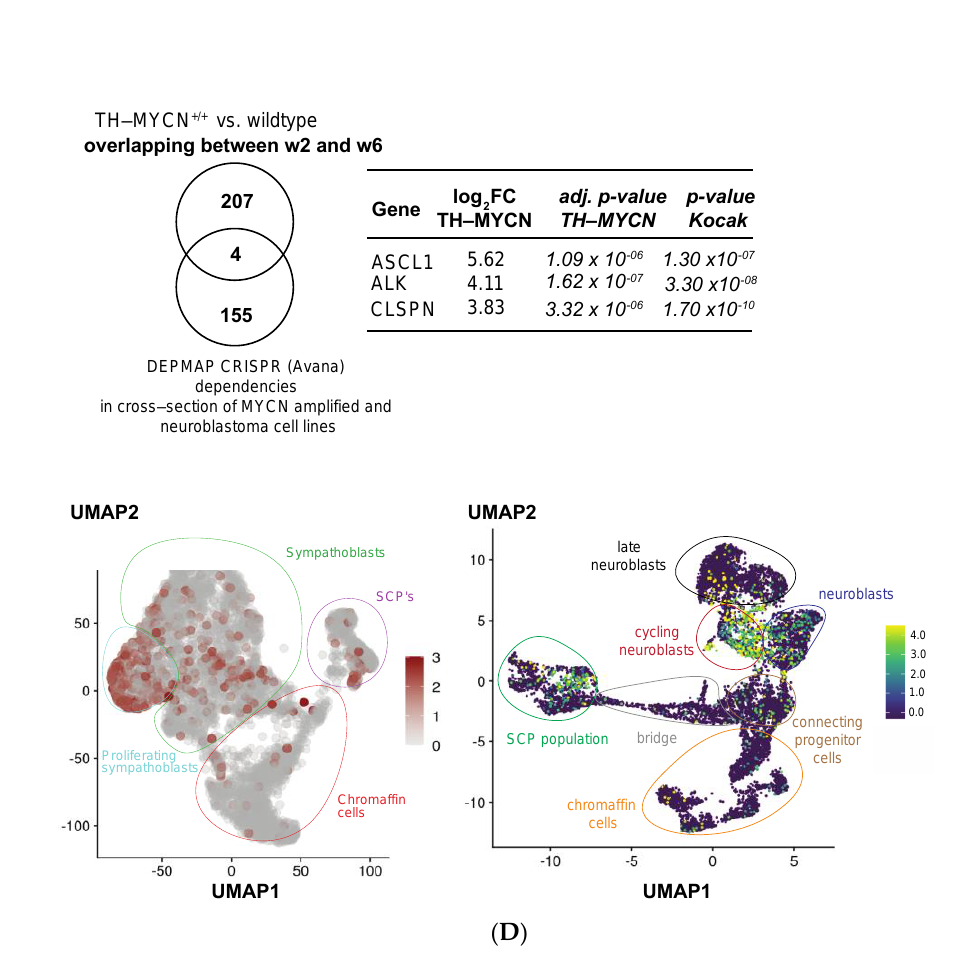
Figure 5. Identification of MYCN-driven dependencies during murine TH-MYCN driven neuroblastoma tumor formation. ( A ) (left) Overlap between upregulated genes in TH-MYCN +/+ versus wild-type samples upon 2 weeks after birth compared to Week 1, with 159 candidate genetic dependencies that were commonly found by the DEPMAP initiative (Avana CRISPR screen) as hits in MYCN-amplified and neuroblastoma cell lines and (right) Overlap between upregulated genes in TH- MYCN +/+ versus wild-type samples upon 6 weeks after birth compared to Week 1, with 159 candidate genetic dependencies that were commonly found by the DEPMAP initiative (Avana CRISPR screen) in MYCN-amplified and neuroblastoma cell lines (left), with an overview of 15 of the overlapping genes significantly correlated with poor overall patient survival in primary neuroblastoma tumors (GSE45547, n = 649) displaying their corresponding log 2 fold change and (adjusted) p -value (right). ( B ) (left) Single-cell analysis of CDCA8 expression in the developing sympathoadrenal lineage points towards nearly exclusive expression in proliferating sympathoblasts [49] (SCP: Schwann cell precursor); (right) single-cell analysis of CDCA8 expression in different cell populations of the adrenal medulla [50]. ( C ) Kaplan–Meier analysis of overall patient survival based on gene expression levels of CBX2 , GJC1 and LIMD2 , encoded on chromosome 17q in a large cohort of 649 primary neuroblastoma patients (GSE45547, n = 649) with high or low expression using median as a cut-off. p -values are a result of a log-rank test. ( D ) (top) Overlap between commonly upregulated genes in TH-MYCN +/+ versus wild-type samples upon 2 and 6 weeks after birth compared to Week 1, with 159 candidate genetic dependencies that were commonly found by the DEPMAP initiative (Avana CRISPR screen) as hits in MYCN-amplified and neuroblastoma cell lines (left), with an overview of 3 of the overlapping genes significantly correlated with poor overall patient survival in primary neuroblastoma tumors (GSE45547, n = 649) displaying their corresponding log 2 fold change and (adjusted) p -value (right); (bottom) (left) Single-cell analysis of CLSPN expression in the developing sympathoadrenal lineage points towards nearly exclusive expression in (proliferating) sympathoblasts [49] (SCP: Schwann cell precursor); (right) Single-cell analysis of CLSPN expression in different cell populations of the adrenal medulla